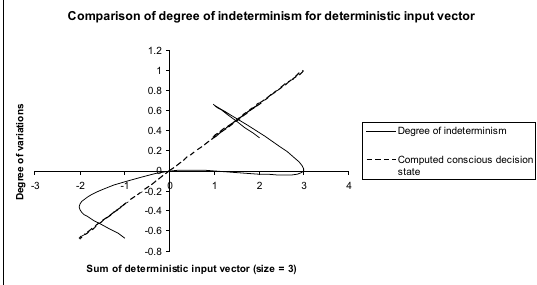
Fig. 12. Variation of state of consciousness in C1 (size = 3). Comparison of degree of indeterminism for combinatorial input vector